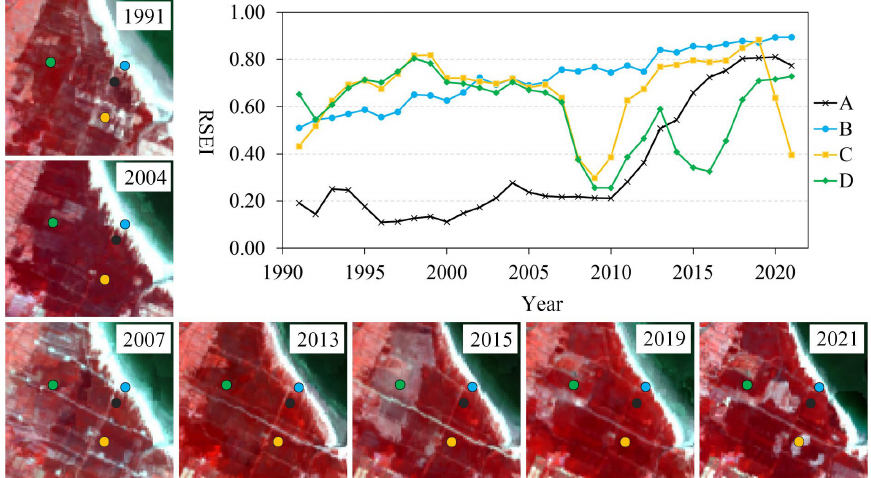
Figure 9. Analysis of RSEI changes in forest area.